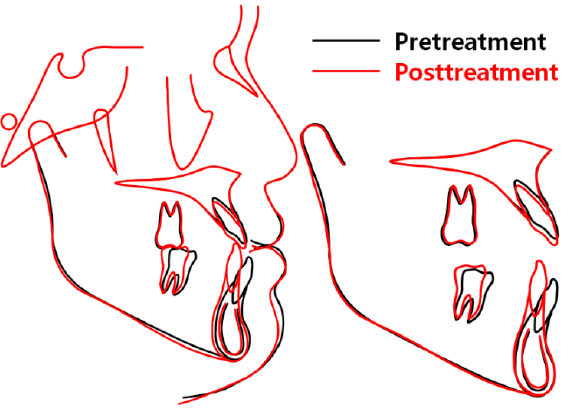
Figure 12. Cephalometric superimposition. Black, pretreatment; Red, pos tt reatment (15 months).